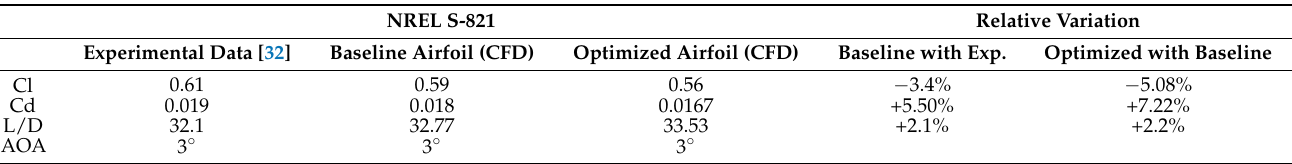
Table 6. Detailed comparison of CFD performance of baseline and optimized airfoils with experimental results (NREL S-821). NREL S-821 Relative Variation Experimental Data [32]